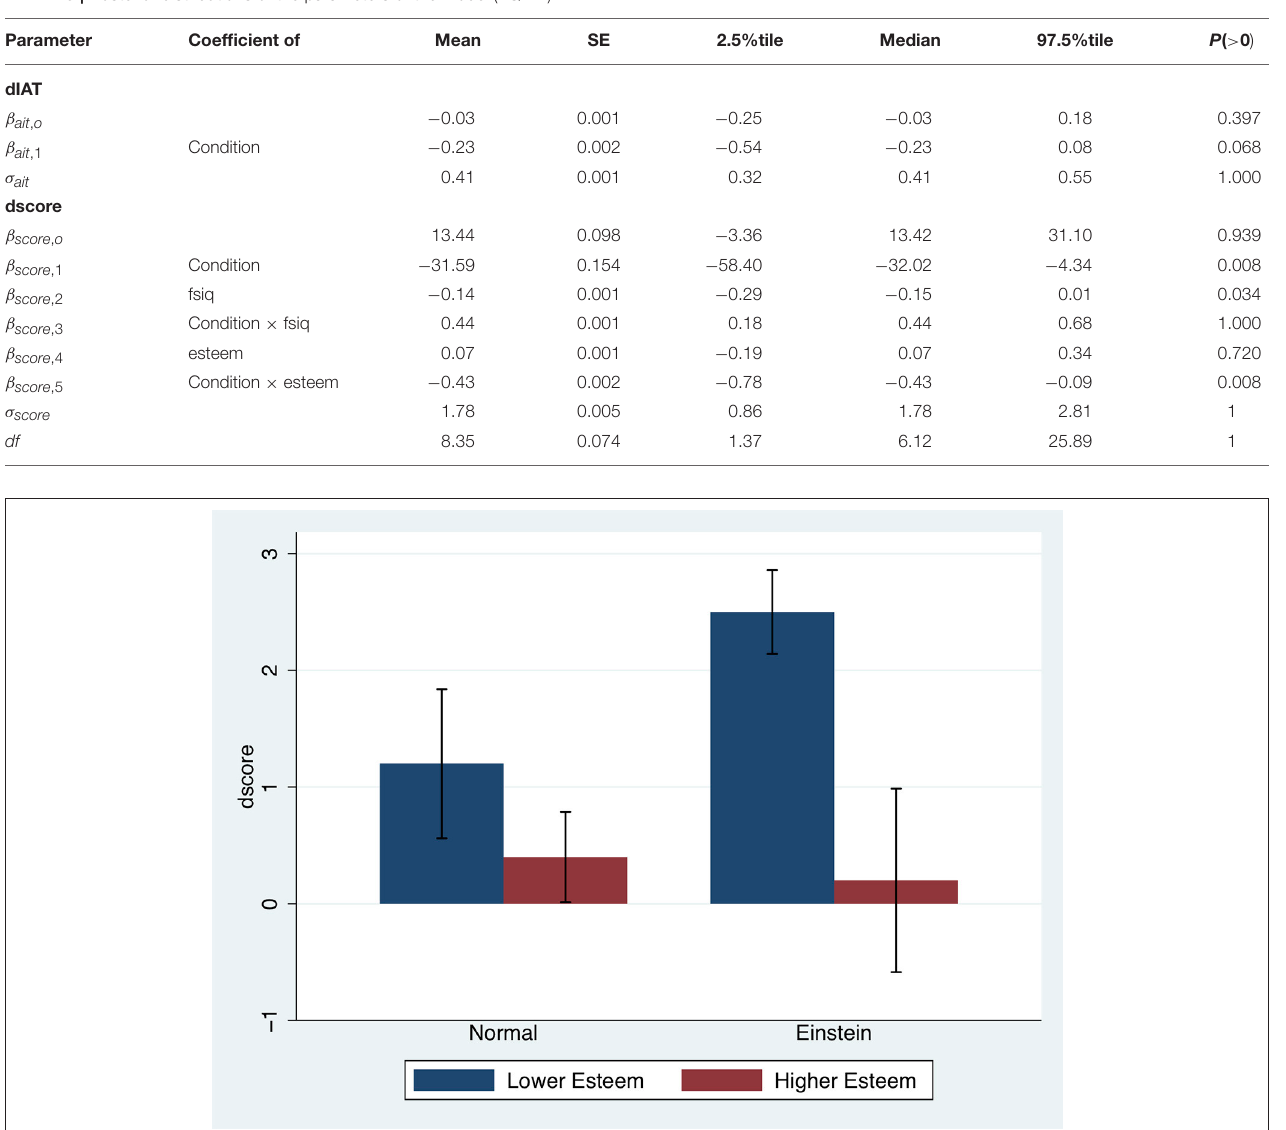
FIGURE 7 | Bar chart showing the means and standard errors of dscore by Body and Esteem. Lower Esteem refers to the group with selfesteem ≤ median of the sample (32.5) and Higher Esteem to those with selfesteem > median.